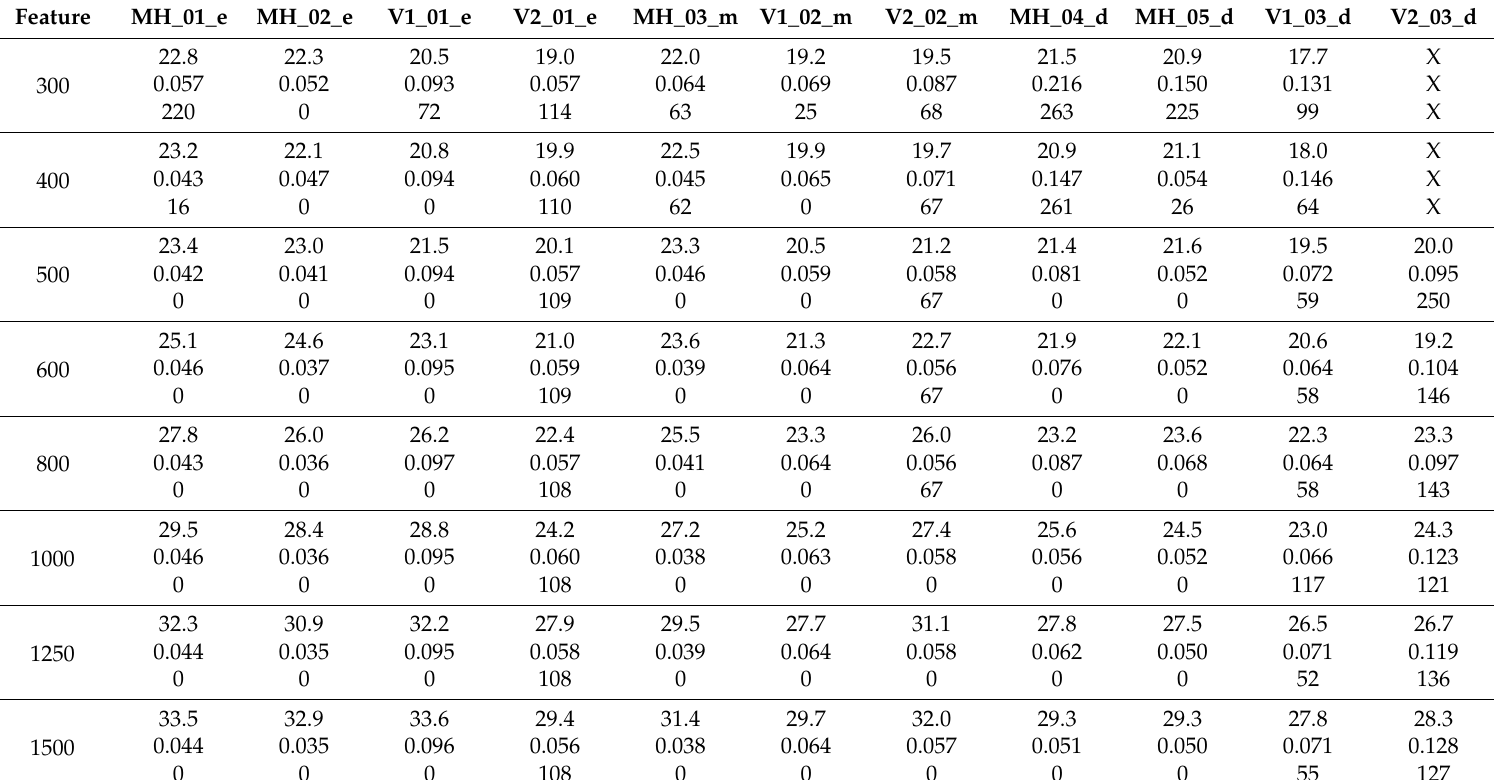
Table 4. Average tracking time, translation RMSE of the keyframe trajectory, and number of lost tracking frames versus the number of features used in the monocular ORB-SLAM with EuRoC